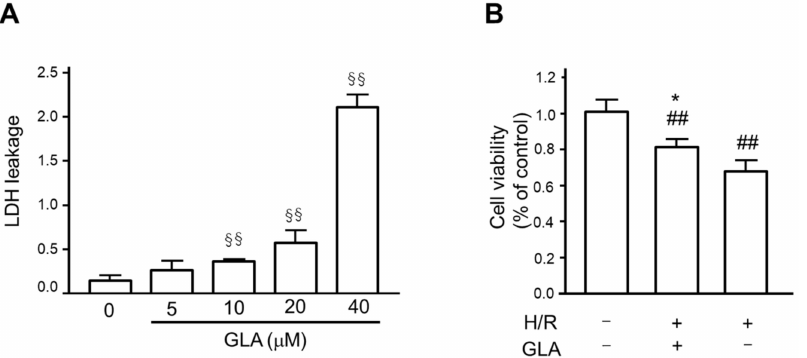
Figure 1. GLA ameliorated cell viability of HK-2 cells. ( A ) To determine GLA concentration, we assessed the cytotoxicity of GLA on HK-2 cells after incubation with a series concentration of GLA (0, 5, 10, 20, and 40 µ M) for 24 h using an LDH assay. LDH leakage was calculated as a fraction of the total LDH activity. §§ p < 0.01 vs. control. ( B ) To assess the protective effect of GLA on the cell viability of HK-2 cells exposed to H/R, we conducted the MTT assay. The cells were pre-treated with 5 µ M GLA for 2 h and then exposed to H/R for 24 h. ## p < 0.01 vs. control (normoxia). * p < 0.05, vs. H/R. Data are shown as the means ± SE for six wells. GLA: glaucocalyxin A; H/R: hypoxia/reoxygenation; LDH: lactate